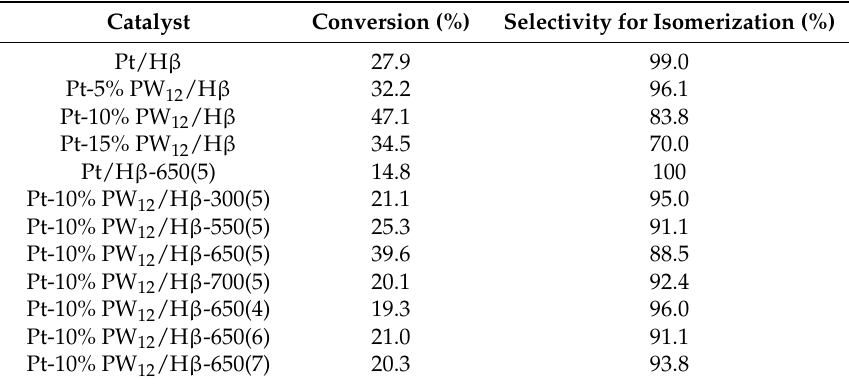
Table 2. Comparison of the activity and selectivity of various catalysts in the hydroisomerization of n -hexane [42] a .